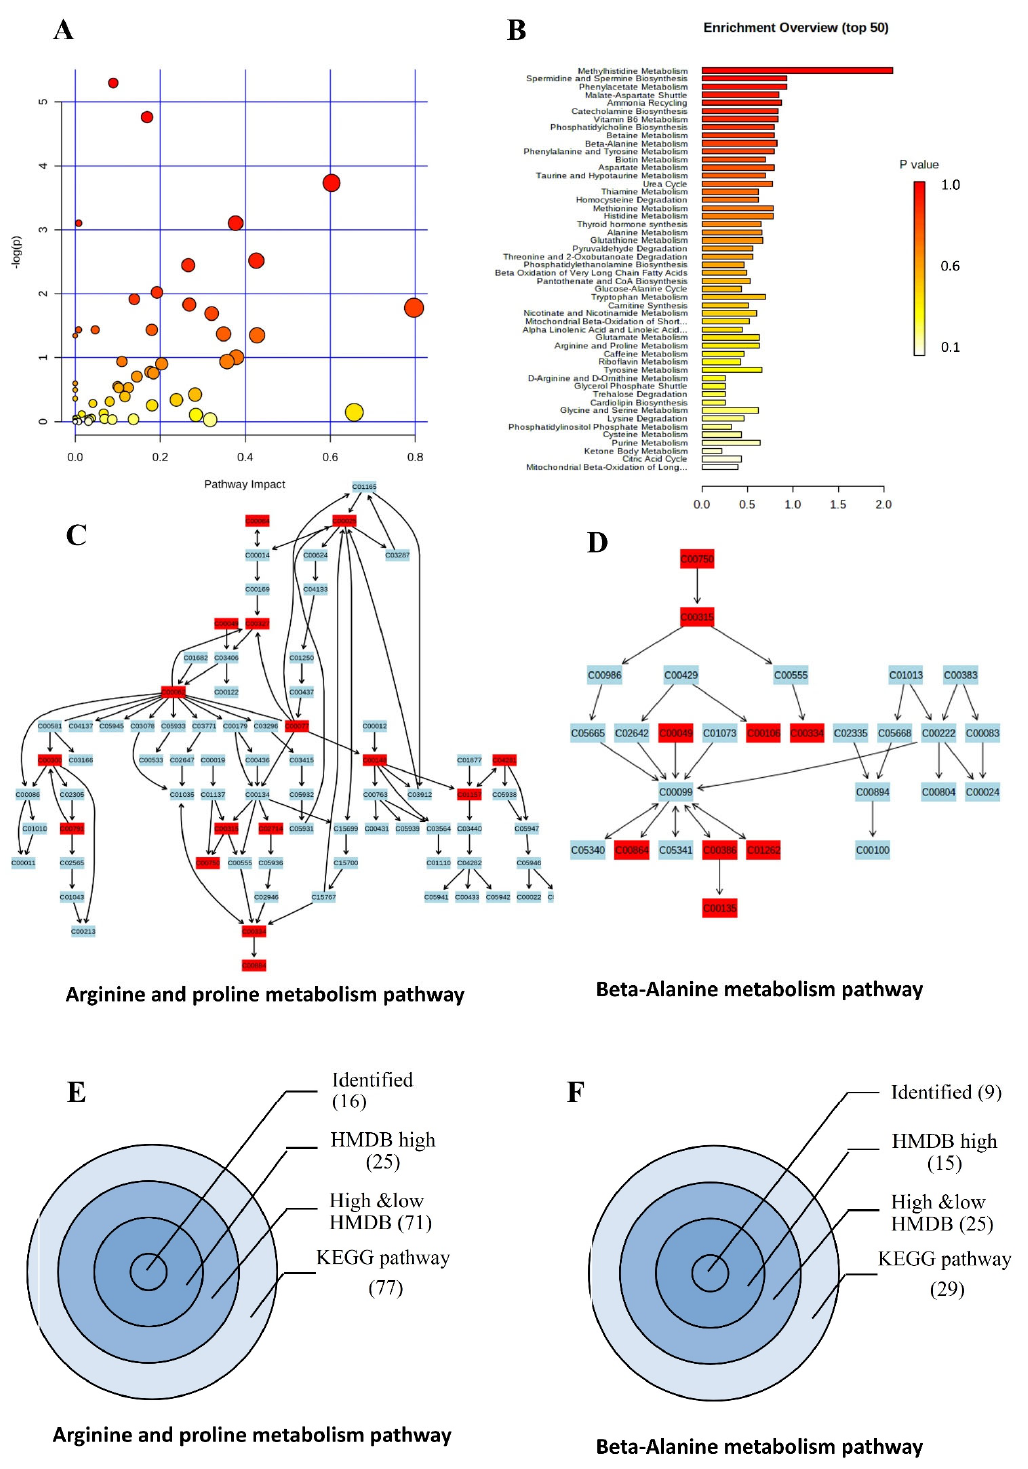
Figure 8. Pathway and enrichment analysis. ( A ) Pathway analysis of identified molecules. The node color recognizes the significance of the aligned molecule ( p value). The node size correlates with the number of molecules identified within a given pathway. ( B ) The enrichment analysis of identified metabolites. Pathway color bars represent the p -value. Two pathways, beta-alanine metabolism ( C ) and arginine-proline ( D ) pathways represent in the KEGG database. Red boxes represent identified molecules within the current experiment. ( E , F ) Identified compounds of both molecules starting from the KEGG